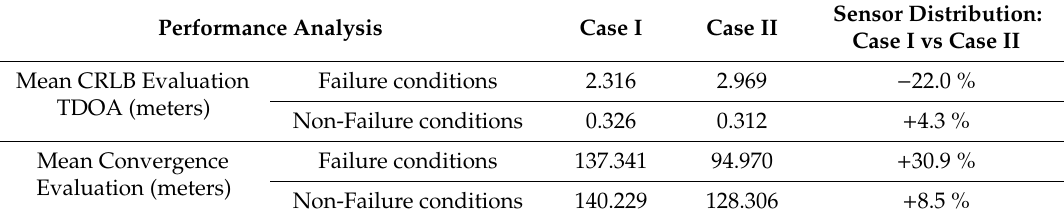
Table 5. Comparative between the optimizations of Case I and II. Values presented show the comparison in relative terms of the failure consideration distribution regarding the optimization for normal operation of the